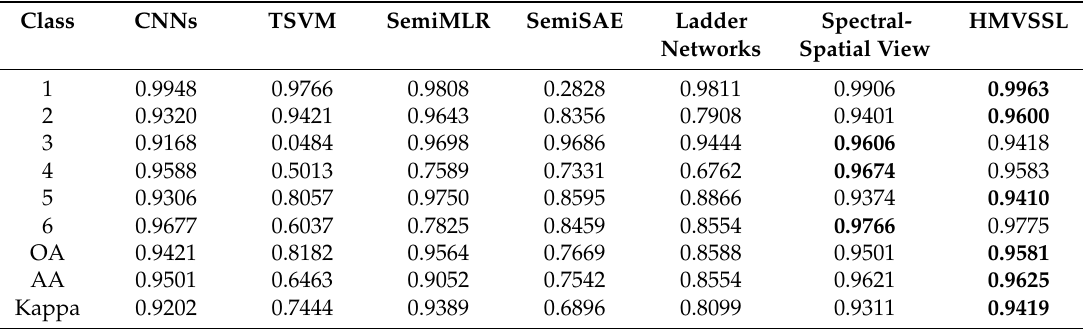
Table 2. Classification accuracies of the compared methods on Aerial data.